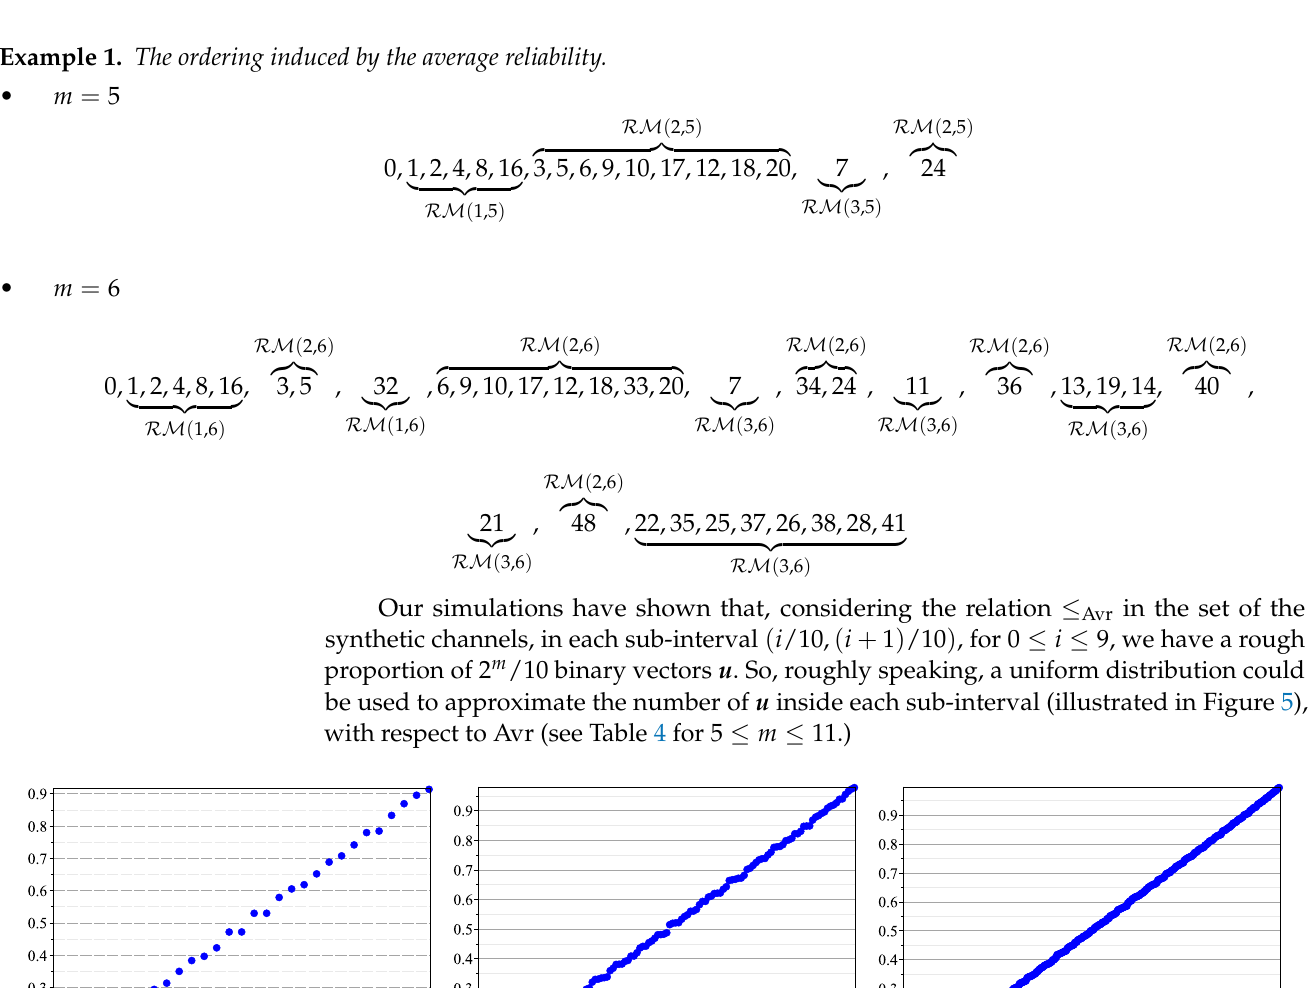
m . 0,1 ∈ { } ( i /10, ( i + 1 ) /10 ] , for 0 ( W u )) B ∈